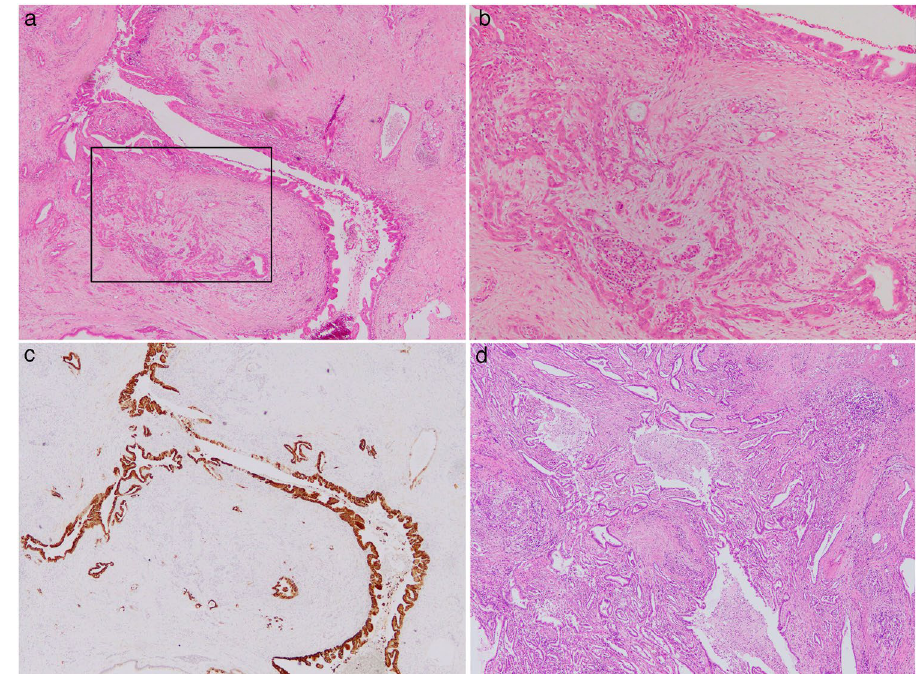
Figure 1. Histopathological images of examined pancreatic ductal adenocarcinomas. The tissue of Case 14 with the somatic mutation of GNAS showed cystically dilated ducts with papillary dysplastic cells ( a ) expressing mucin 5AC ( c ) close to solid invading tumors ( b ) the higher magnification image of inset in ( a )), which indicates that this carcinoma was associated with IPMN. The tissue of Case 30 with the germline mutation of MLH1 showed pathological findings of usual ductal adenocarcinoma with dense stromal fibrosis ( d ). ( a , b and d ), hematoxylin and eosin staining, and (c) indirect immunohistochemical staining. Original magnification, × 40 ( a ) × 100 ( b ) × 40 ( c ) and × 40 ( d